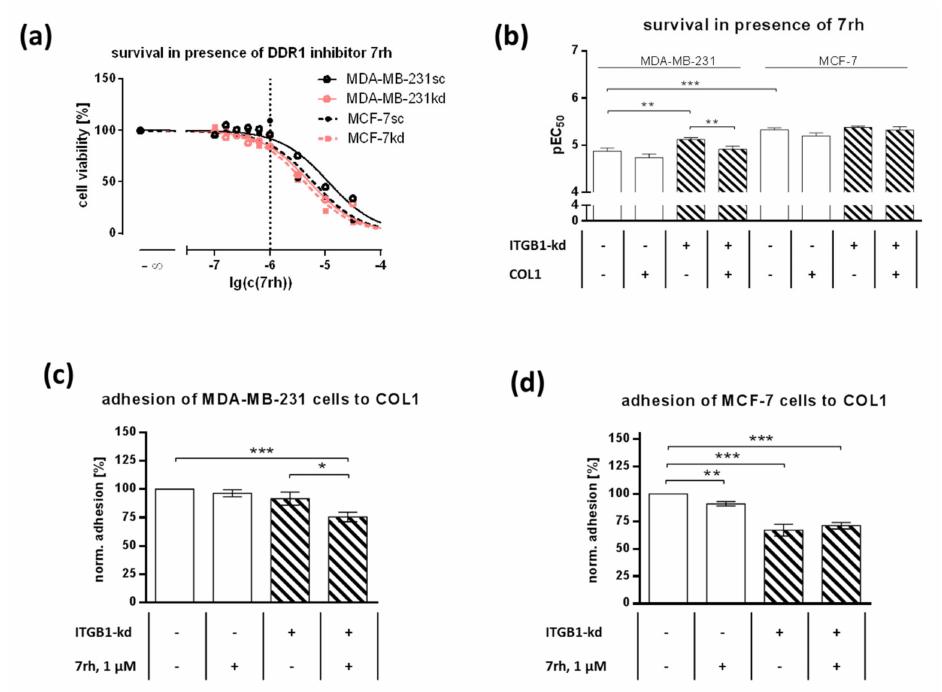
Figure 2. ( a ) Representative survival curves of MDA-MB-231 and MCF-7 cells (scrambled, sc) and their integrin β 1 -knockdown (ITGB1-kd) mutants on collagen type 1 (COL1) in the presence of DDR1-inhibitor 7rh for 72 h. The nontoxic concentration of 1 µ M, used for adhesion studies in ( c , d ) is marked. ( b ) Statistical analysis of survival pEC 50 of DDR1-inhibitor 7rh in MDA-MB-231 and MCF-7 scrambled and ITGB1-kd cells in the presence and absence of COL1. Data represent means ± SEM of at least n = 11 biological replicates. ( c , d ) Adhesion of MDA-MB-231 cells ( c ) and MCF-7 cells ( d ) and their ITGB1-kd mutants on COL1 in the presence or absence of DDR1-inhibitor 7rh. Data represent means ± SEM of n = 6 di ff erent biological replicates. Statistical analysis was performed via unpaired t -test (* p < 0.05; ** p < 0.01; *** p <